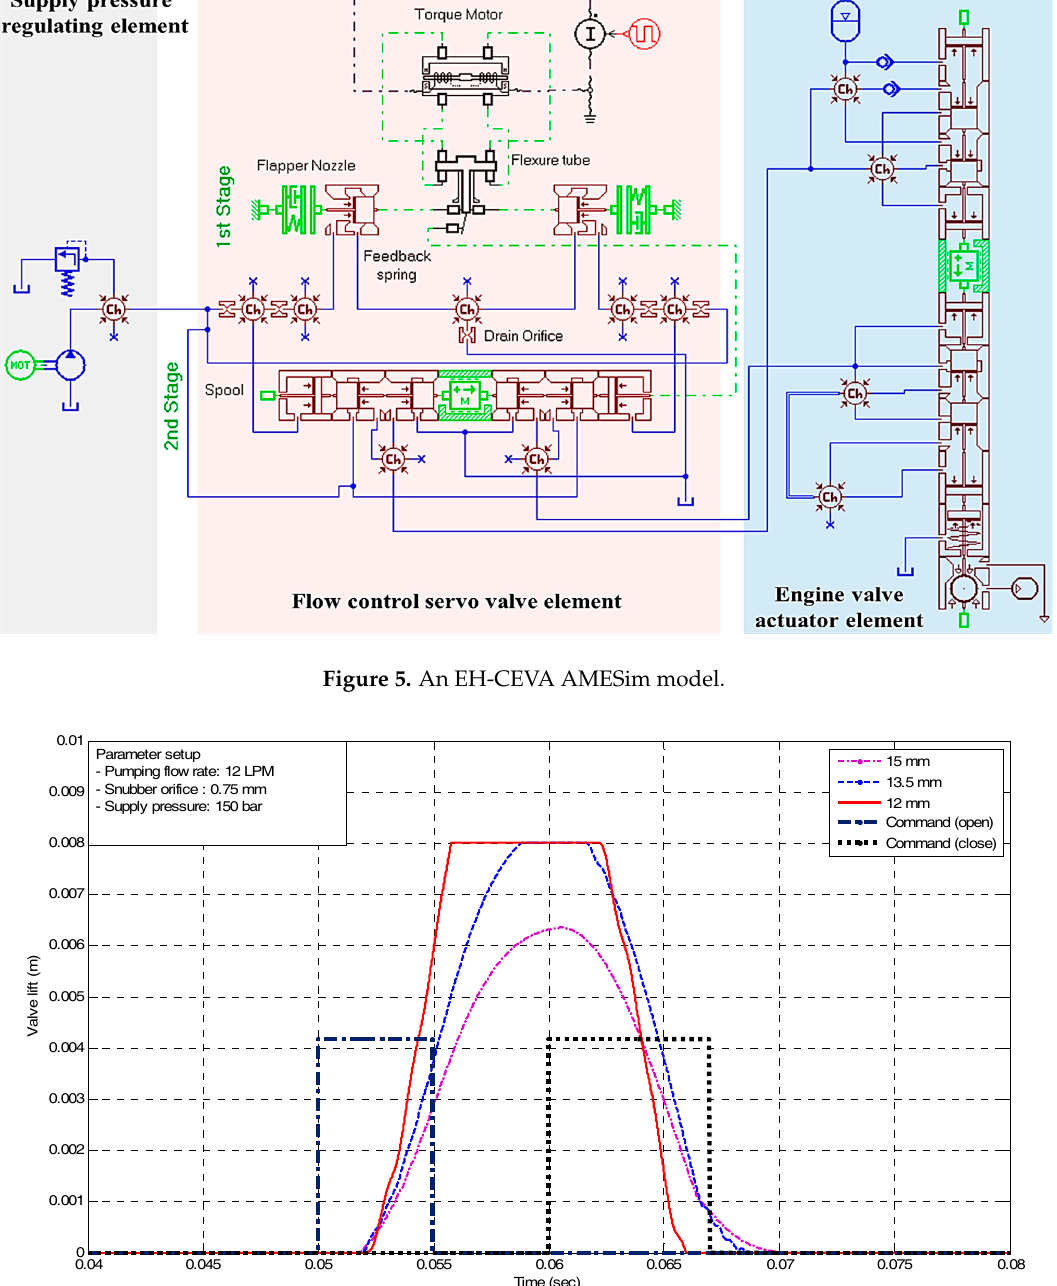
Figure 6. Simulation results for design parameter (e.g., piston diameter) variation.